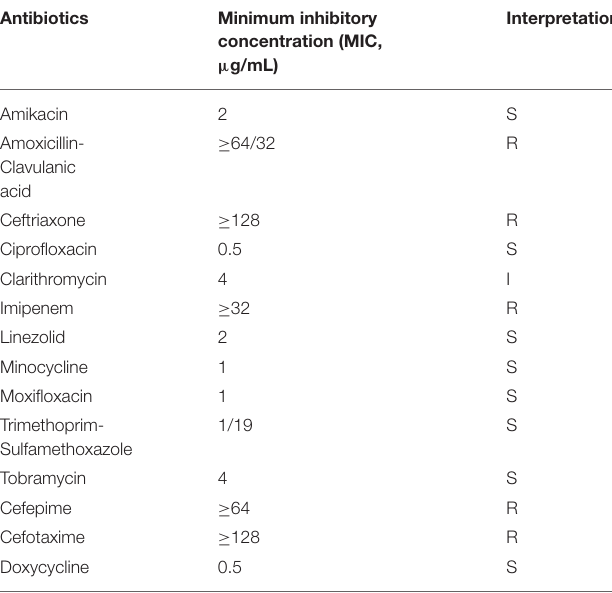
TABLE 1 | The antibiotic susceptibility of Nocardia huaxiensis . Antibiotics Minimum inhibitory concentration (MIC, µ g/mL)